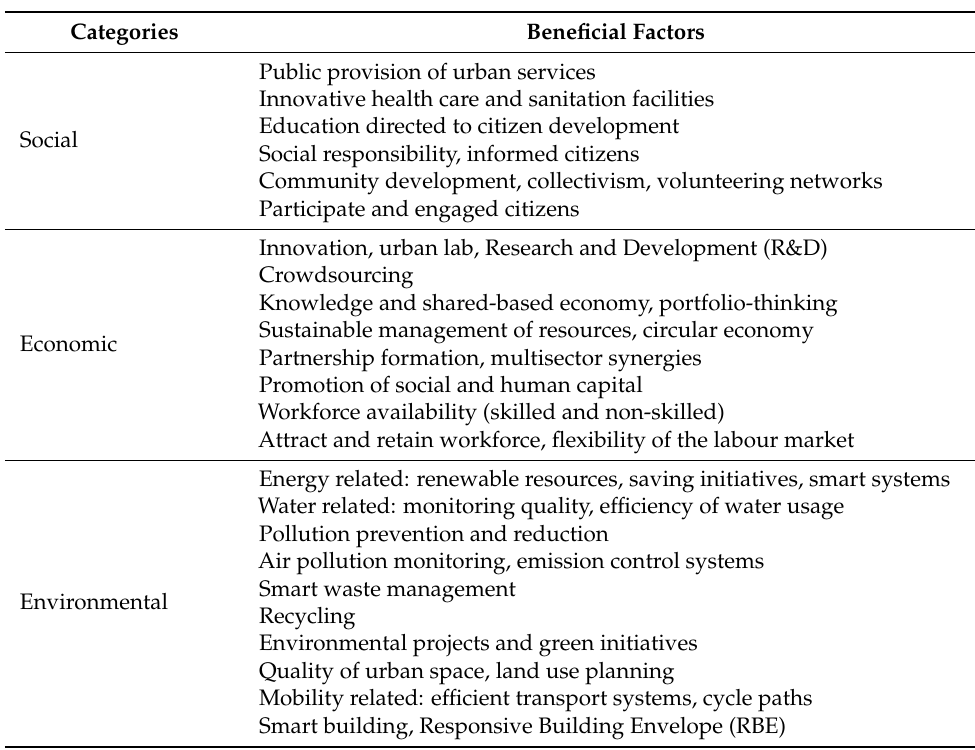
Table 8. A cumulative list of the beneficial factors of a smart city [99].